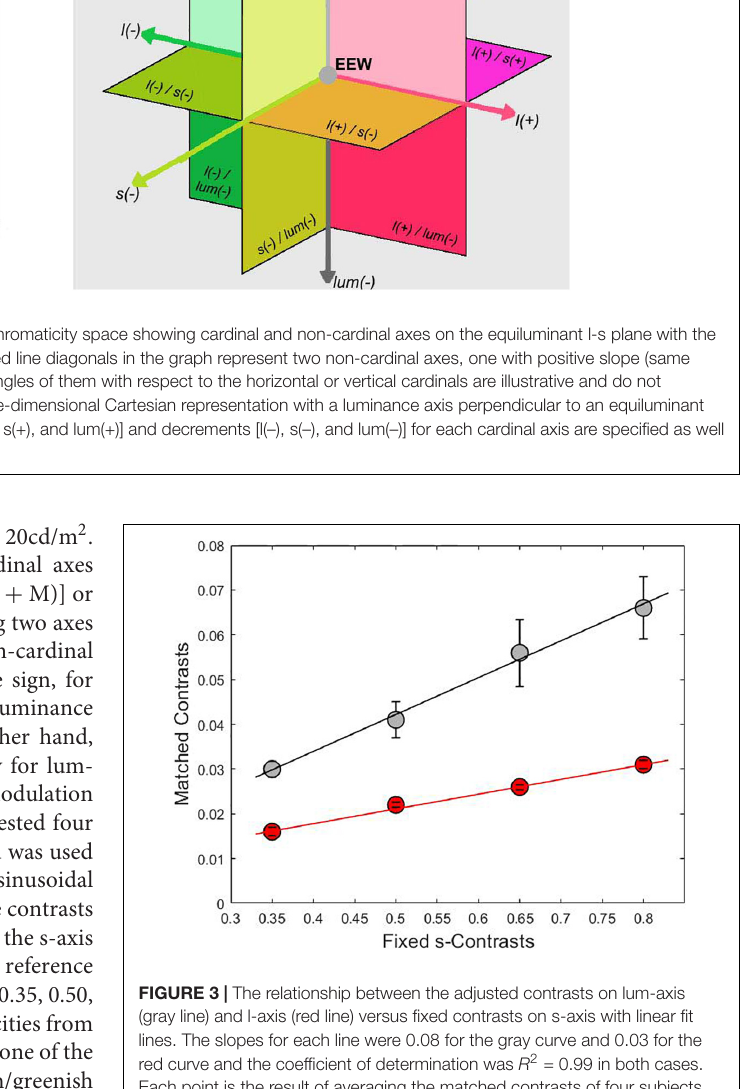
FIGURE 3 | The relationship between the adjusted contrasts on lum-axis (gray line) and l-axis (red line) versus fixed contrasts on s-axis with linear fit lines. The slopes for each line were 0.08 for the gray curve and 0.03 for the red curve and the coefficient of determination was R 2 = 0.99 in both cases. Each point is the result of averaging the matched contrasts of four